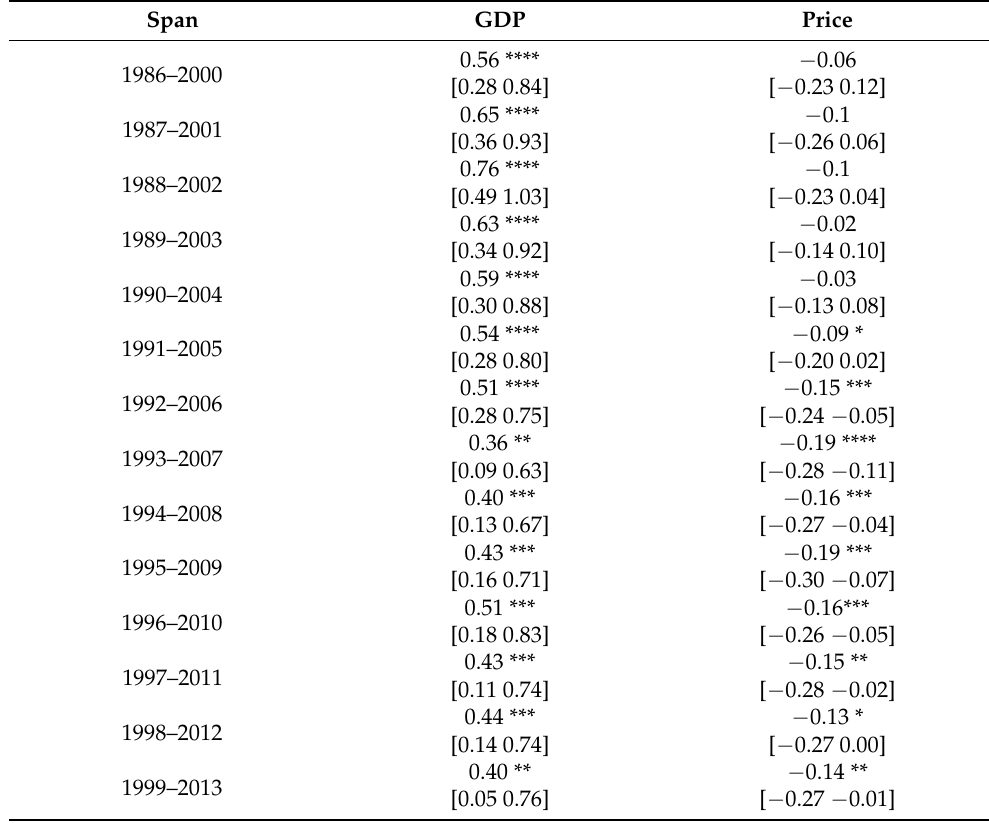
Table 3. Long-run elasticity estimates from 15-year rolling window CCE regressions (static model), 28 OECD countries, 1986–2019 (balanced